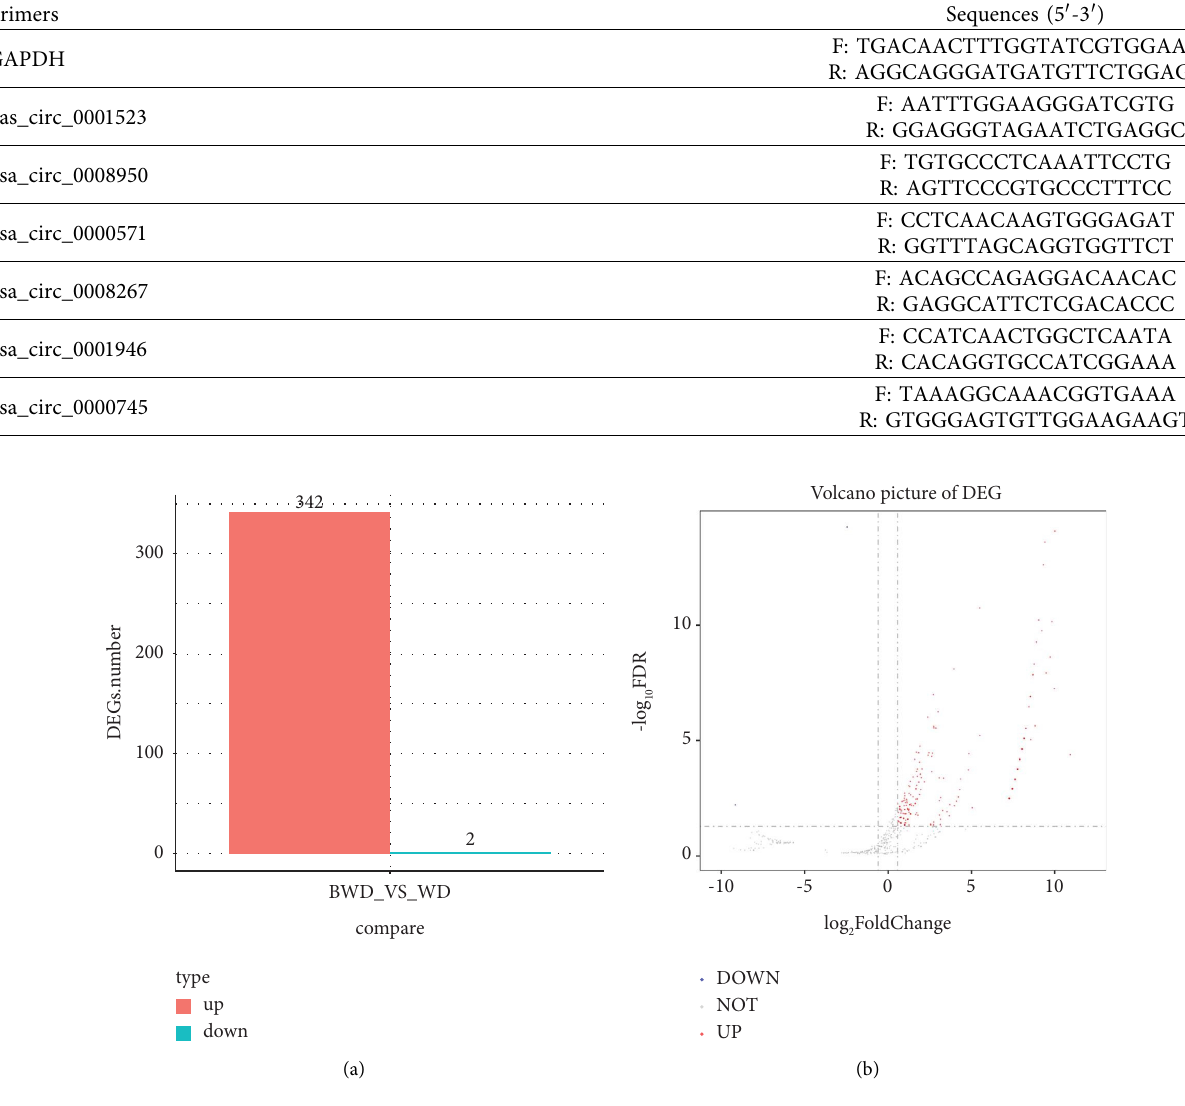
Figure 1: Profles of circRNAs and their diferential expressions comparing stable and unstable plaques. (a) Te histogram displays 342 diferentially expressed upregulated circRNAs and 2 downregulated circRNAs in unstable plaques, as compared with those of stable plaques. (b) Te volcano plot shows the diferentially expressed (DE) circRNAs in unstable plaques. Te horizontal dashed-dotted line shows the adjusted P value of 0.05, and the vertical dashed-dotted lines represent the twofold change in genes. For the unstable plaques, upregulated circRNAs are indicated by red points, and downregulated circRNAs are displayed as blue points.